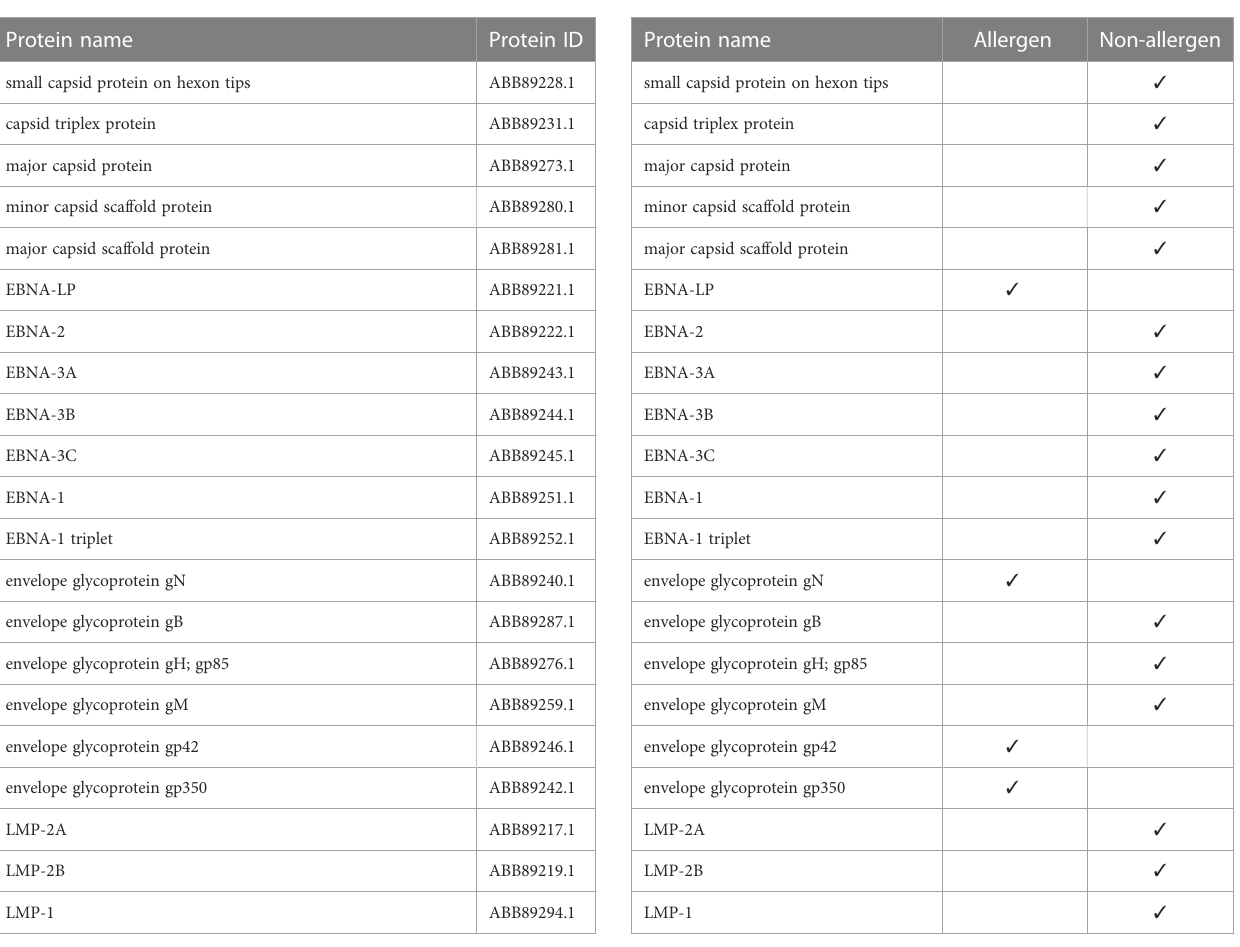
TABLE 3 Allergen and non-allergen proteins in strain 2. TABLE 2 Selected proteins from an assembly of human herpesvirus